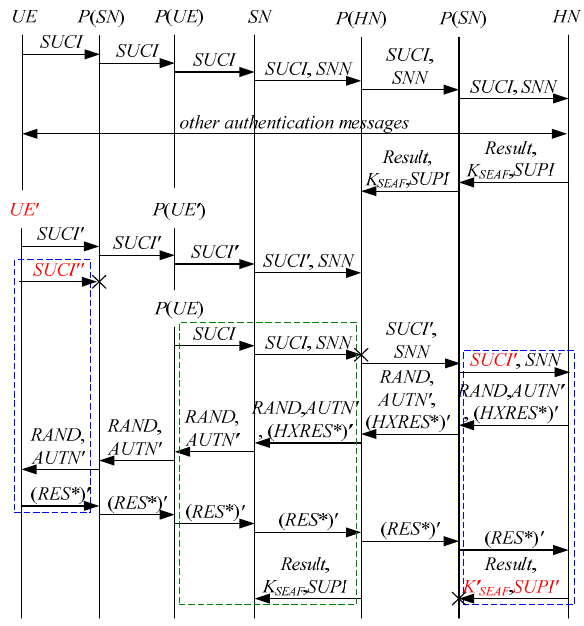
Figure 15. The fourteenth attack scenario of the 5G AKA protocol.